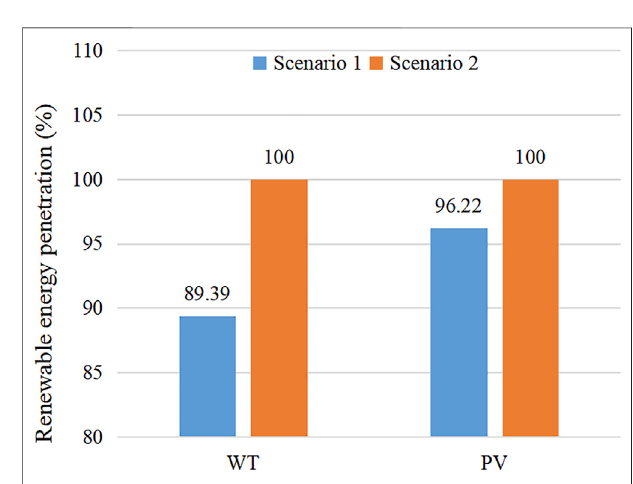
FIGURE 11 | Renewable energy penetration in Scenarios 1 and